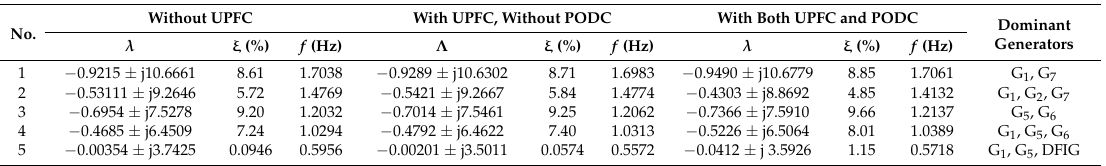
Table 6. Interarea oscillation modes in three cases.